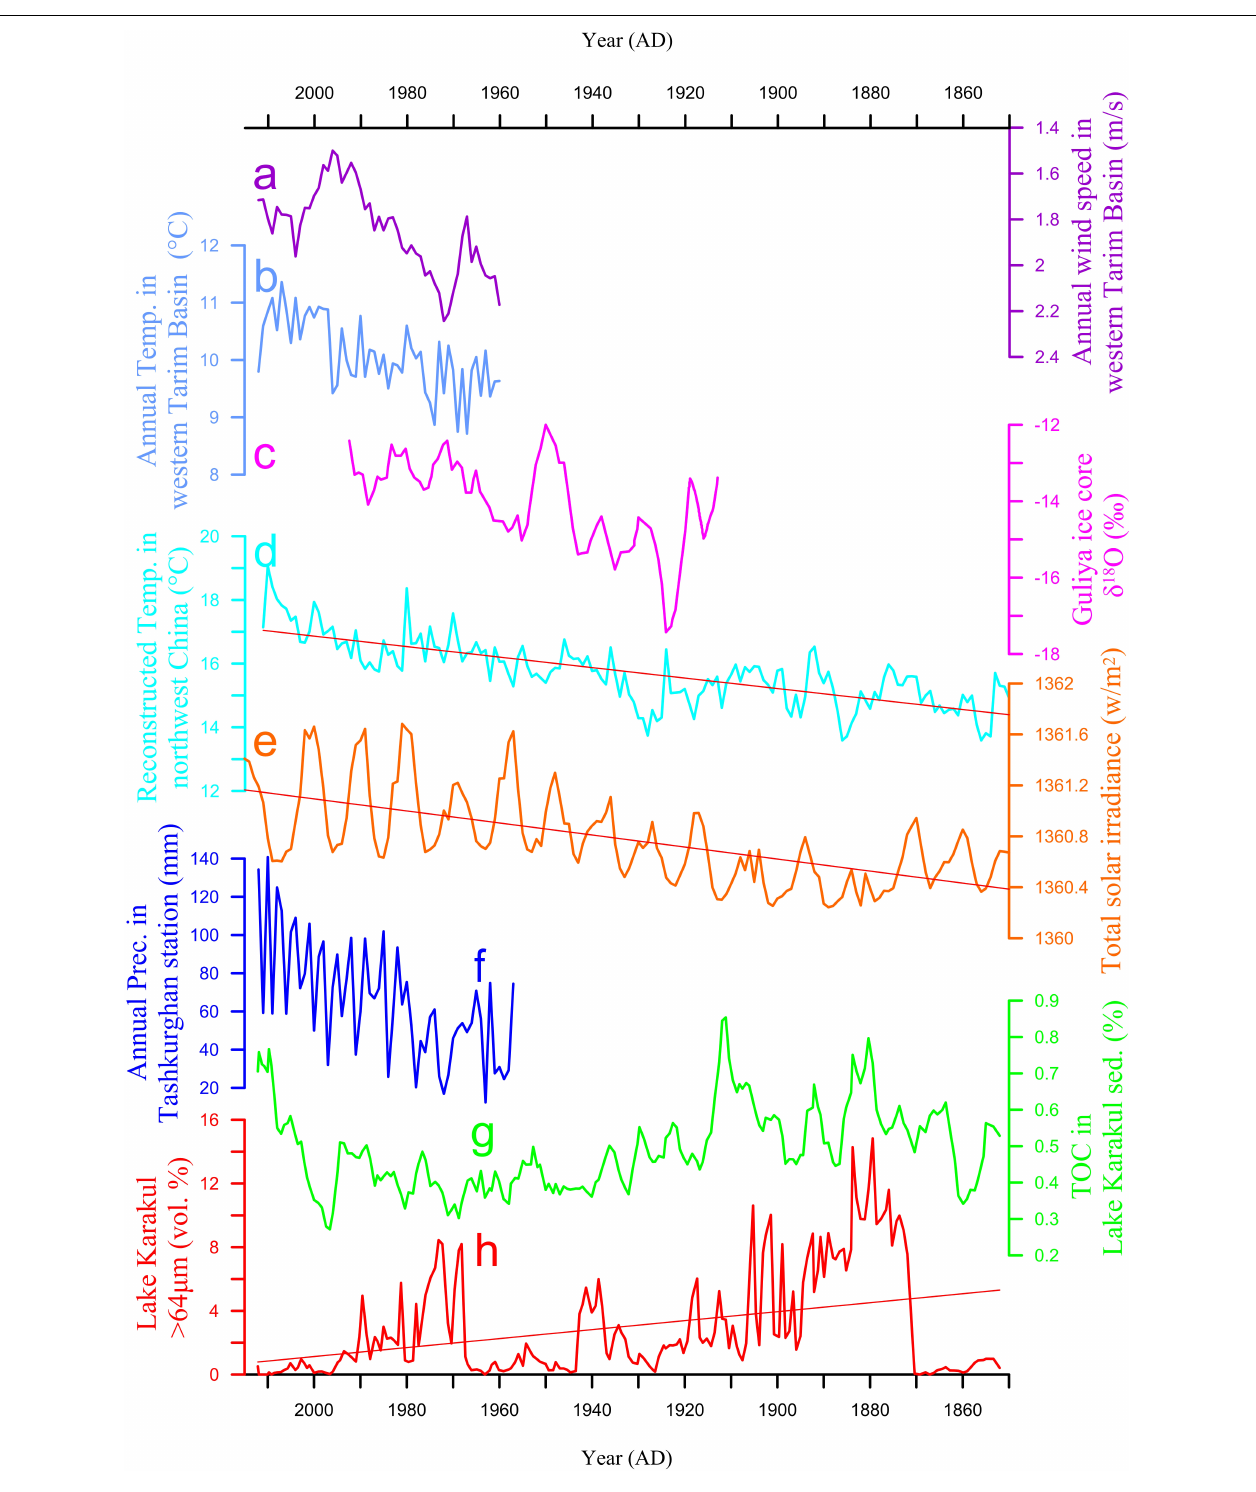
FIGURE 5 | Comparison between the dust storm records at Lake Karakul (curve h; this study), annual mean wind speed (curve a; note it is inversely plotted), and temperature (curve b) recorded by 11 stations in the western Tarim Basin ( Supplementary Table S1 and Figure 1a ), δ 18 O in Guliya ice core (curve c; Yao et al., 2006), the reconstructed temperature in northwest China by tree-ring width (curve d; Liu et al., 2016), total solar irradiance (curve e; Coddington et al., 2016), annual precipitation recorded at Tashkurghan station (curve f), and sedimentary TOC in Lake Karakul sediments (curve g; Yan et al., 2019). Red thin lines in plots d, e, and h show the linear